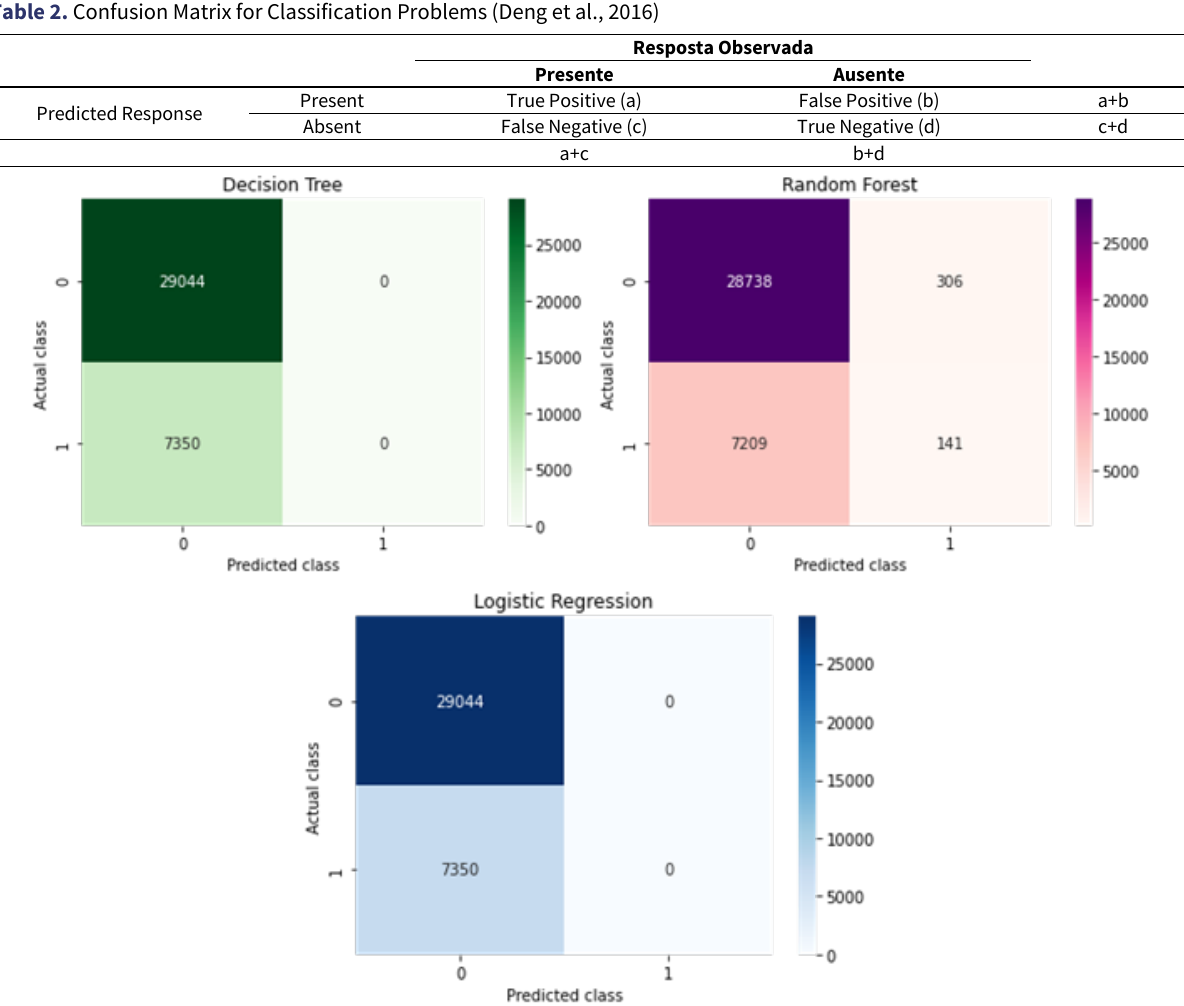
Figure 4. Confusion matrix obtained for decision tree, logistic regression and random forest